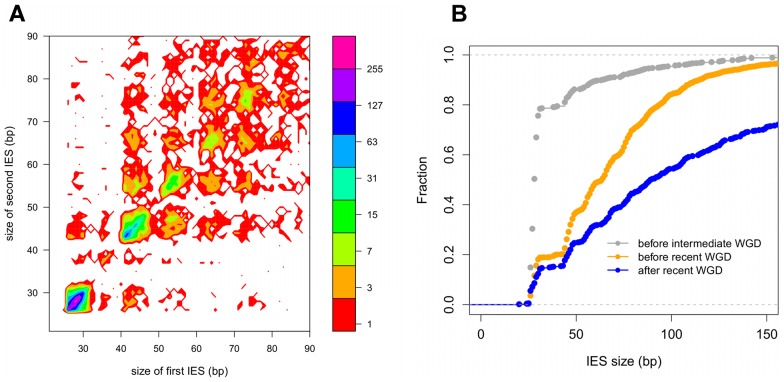
IES conservation in genes related by WGD.A) Filled contour plot of the correlation between the size of IES pairs that have been conserved with respect to the recent WGD. The x axis gives the size in bp of the first IES, the y axis gives the size in bp of the second IES found in the ohnologous gene and the color of each point indicates the number of times that combination of x,y values was found in the data set. The color legend is shown to the right of the figure, the numbers represent counts of the x,y value pairs; the rainbow colors are distributed according to a log2 scale. B) Size distribution of IESs conserved in “quartets” i.e. genes that are still present in 4 copies in the genome after duplication at both the intermediate and the recent WGD events. In order to compare size distributions for different classes of IES, they are represented as experimental cumulative distribution functions. The ripples in each curve correspond to the peaks of a histogram representation as in Figure 3A. The curves are for IESs that must have originated from an ancestral IES acquired before the intermediate WGD (grey, N1111 IESs), IESs that must have originated from an ancestral IES acquired before the recent WGD (orange, N1100 IESs) and the IESs that might have been acquired since the recent WGD (blue, N1000 IESs).